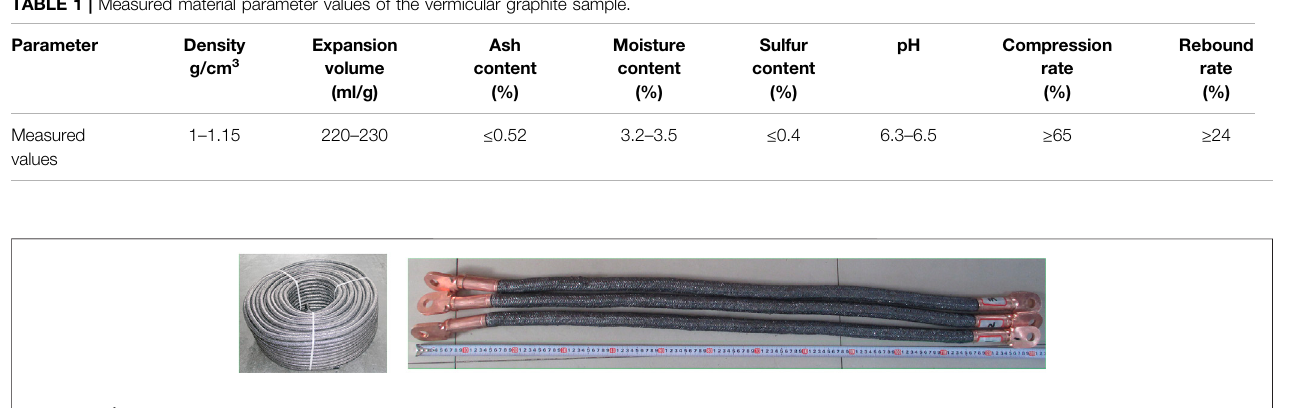
FIGURE 2 | Test sample of fl exible graphite composite electrical grounding material